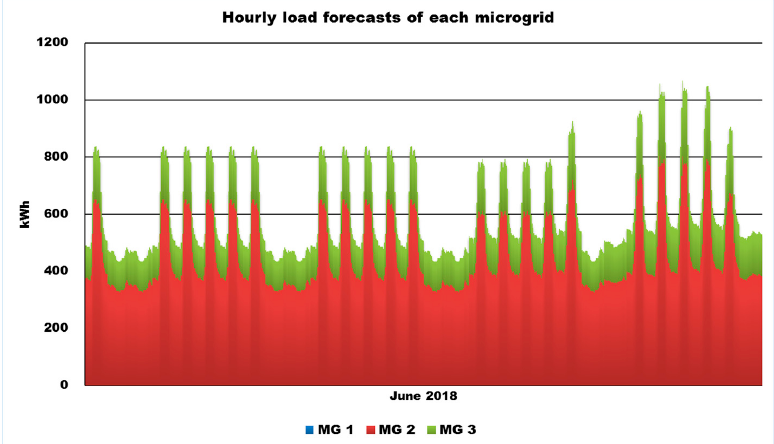
Figure 6. Hourly load forecasts of each microgrid.